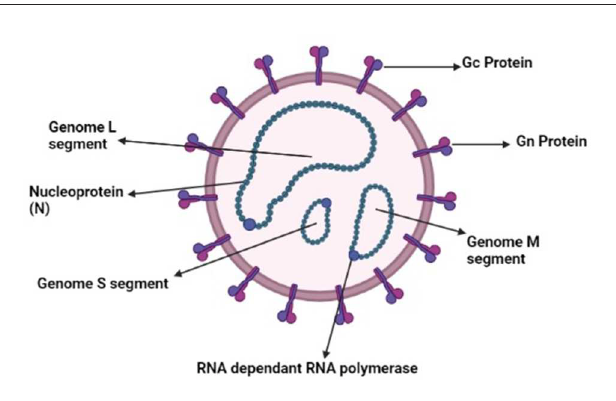
FIGURE1 Schematic diagram of Nairo virus (Drawn by BioRender